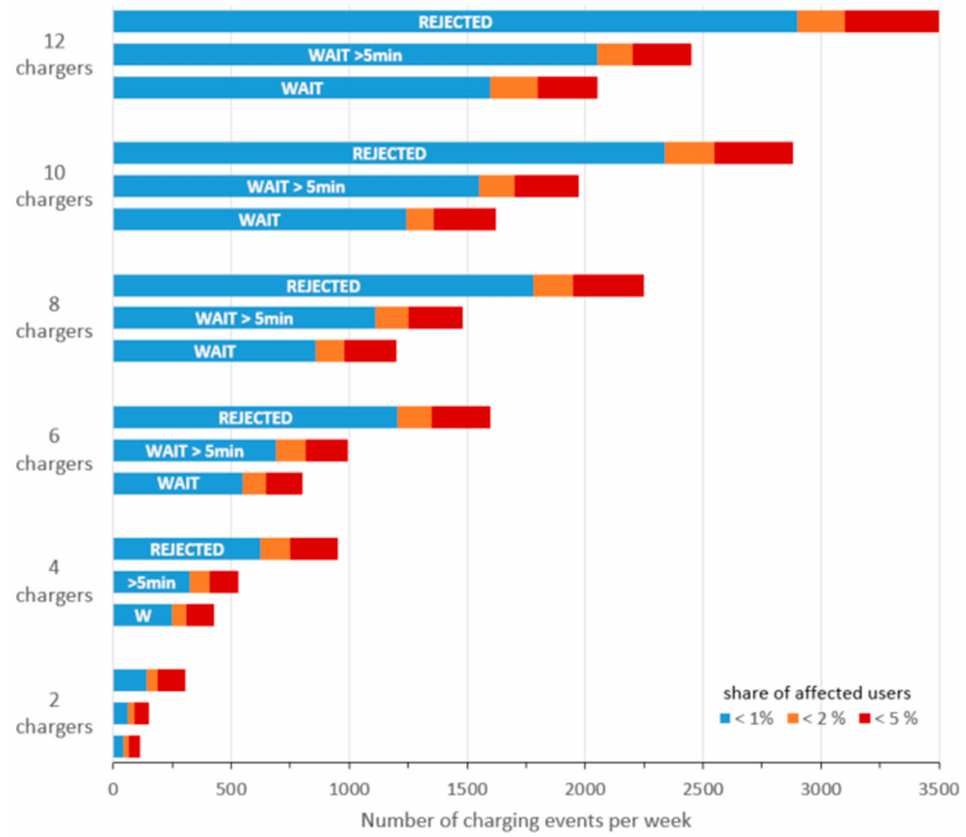
Figure 5. Waiting metrics as a function of the number of charging points and charging events per